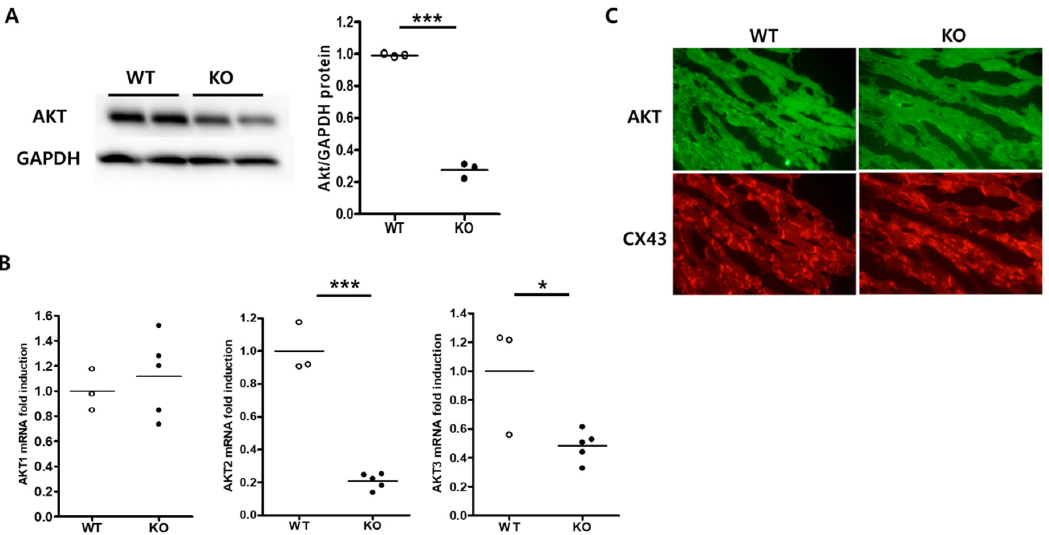
Figure 1. Generation of cardiac-specific AKT2 knockout mice. Protein and RNA were extracted from wild-type (WT) and AKT2 knockout (KO) mouse hearts. ( A ) Proteins were subjected to Western blot analysis using the indicated antibodies. Total AKT immunoblotting bands indicate the fold changes of total AKT normalized to GAPDH bands. ( B ) AKT1, -2, and -3 mRNA levels were determined by real-time PCR. ( C ) Heart sectioned and subjected to immunofluorescence staining. AKT (green) and connexin-43 (red) in WT and AKT2 KO hearts. All data are means ± s.e.m from three independent experiments (scale bar, 100 µm). * p < 0.05, *** p < 0.001 according to a two-tailed Student’s t -test.